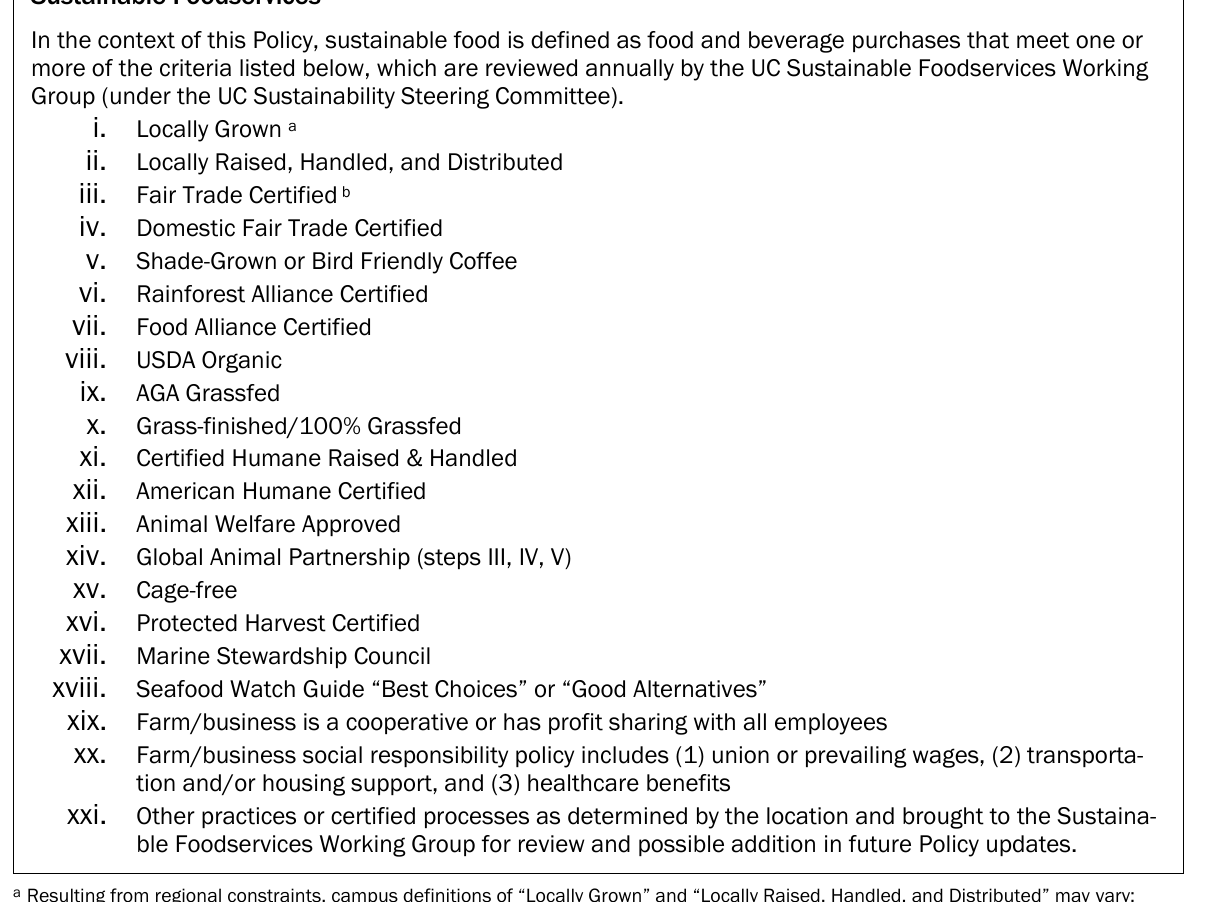
Table 1. The University of California ’ s Definition of Sustainable Food from its Policy on Sustainable Practices, 2009 – 2019 Sustainable